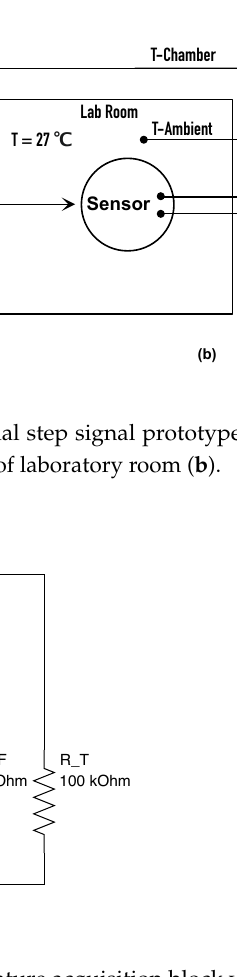
Figure 7. Schematics of the ADC temperature acquisition block with reference resistor R-REF and thermistor